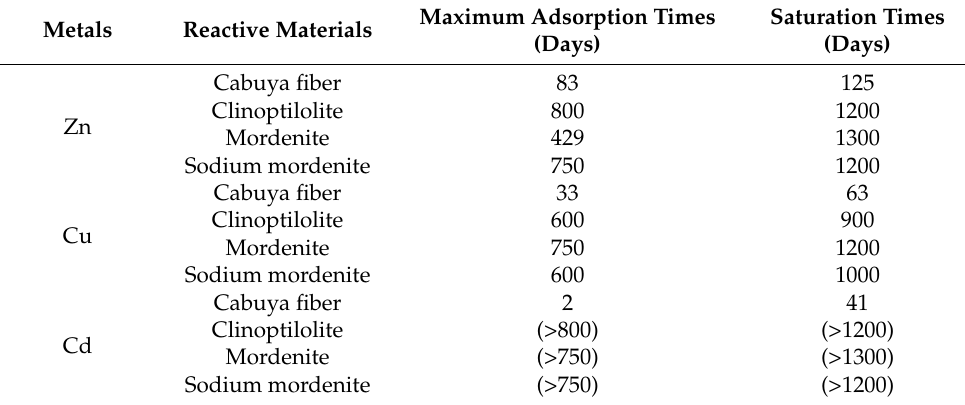
Table 9. Maximum adsorption and saturation times obtained by simulation with the RETRASO code for each reactive material and for the transition metals